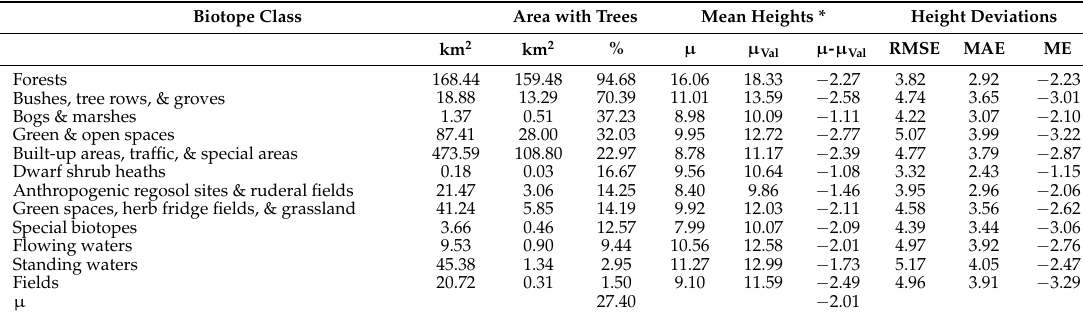
* The mean heights are weighted with the fractions of each biotope class layer on the pixels of the respective CHMs. Table 4. Area with trees (km 2 Veg , trees %), Weighted mean vegetation heights ( µ ) and validation heights ( µ VAL ) and height deviations to validation heights (RMSE, MAE, and ME in meters) for trees in 12 biotope classes.